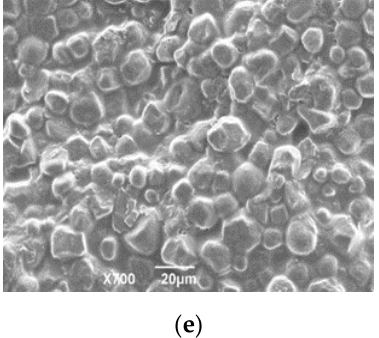
Figure 5. The in vitro release of TIL-SLNs ( a ), the in vitro release of enteric granules ( b ), SEM imaging of the enteric granules when incubated with SIF for 30 min ( c ), and the coting membrane of enteric granules in SGF ( d ) and SIF ( e ) after 30 min incubation. The release rate of TIL-SLNs in SGF was reduced after enteric-coating and the intact TIL-SLNs was observed after the enteric granules were incubated with SIF medium for 30 min.